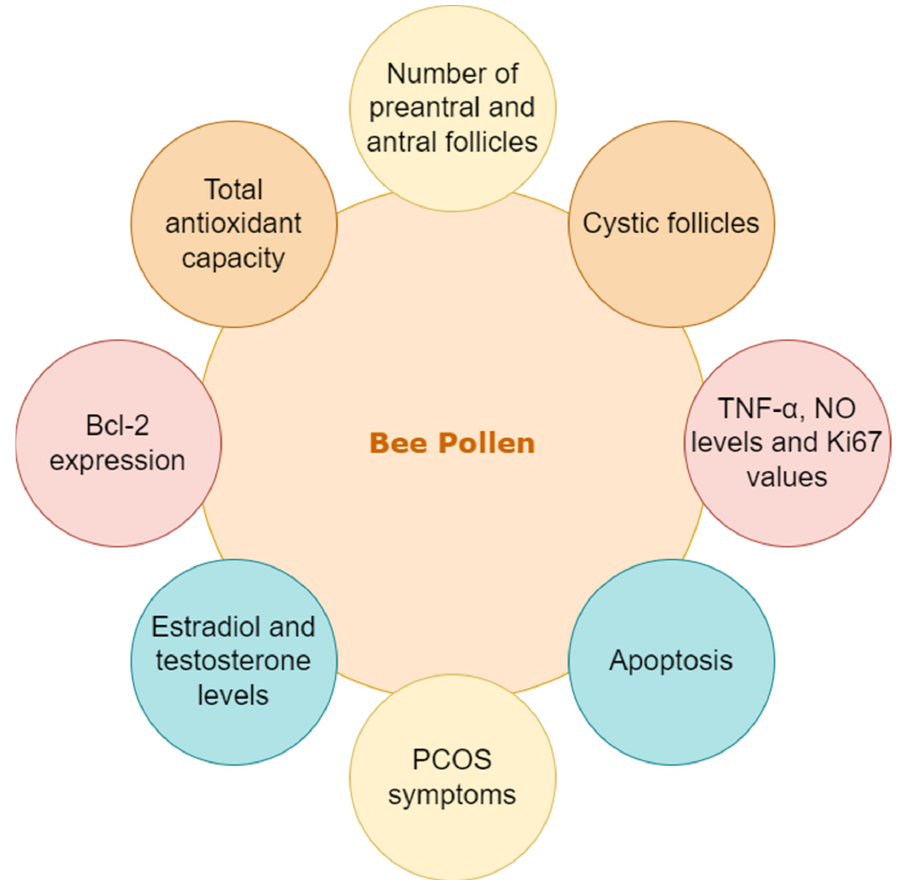
Figure 6. Bee pollen affected parameters related to